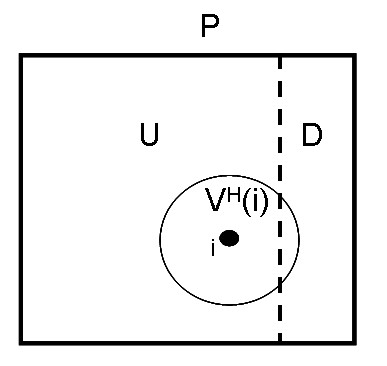
Schematics of the relation between the sets P, U, D, and VH(i).